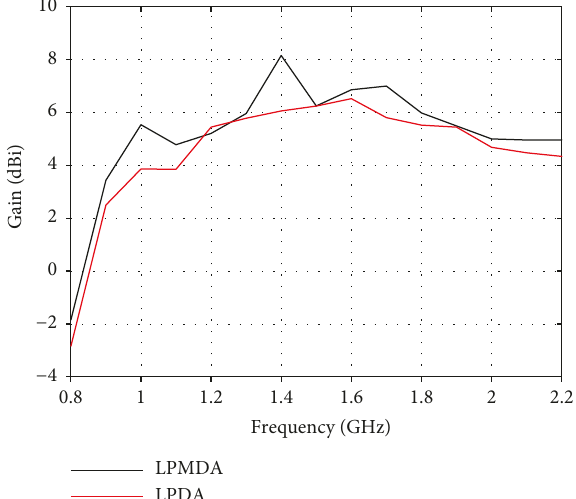
Figure 5: Simulated gains of the LPDA antenna and LPMDA antenna in the main beam direction.